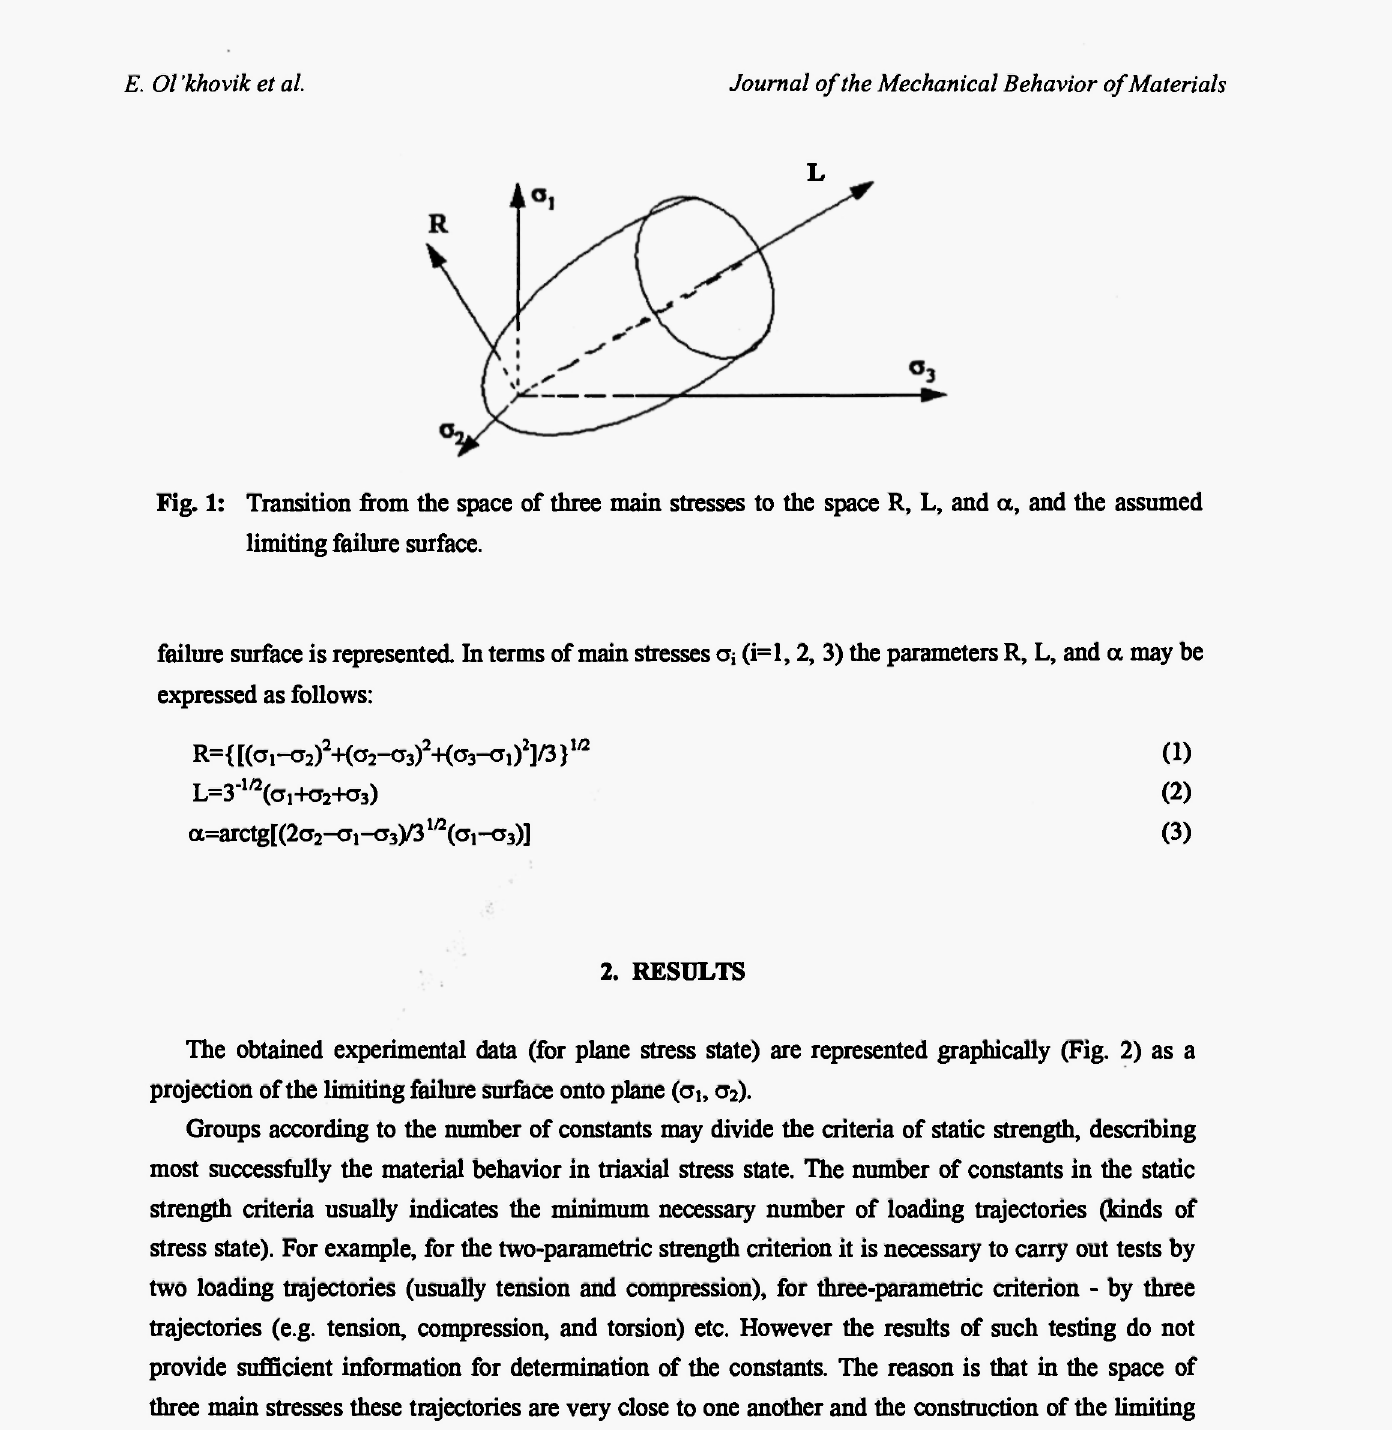
Fig. 1: Transition from the space of three main stresses to the space R, L, and a, and the assumed limiting failure